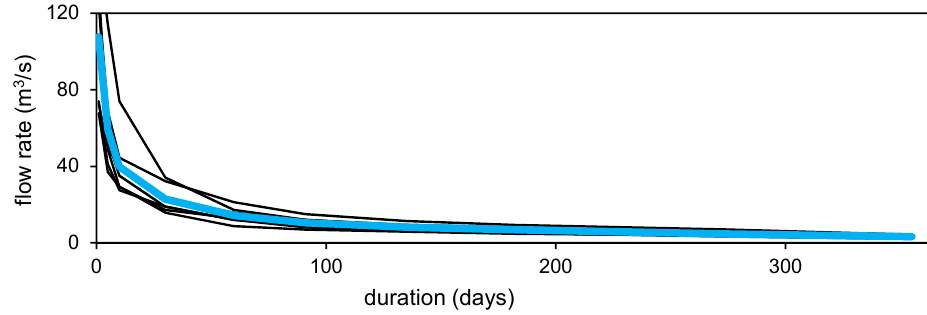
Figure 5. Flow duration curve at Sondrio (data from 1992 to 1998 in black, average curve in blue).